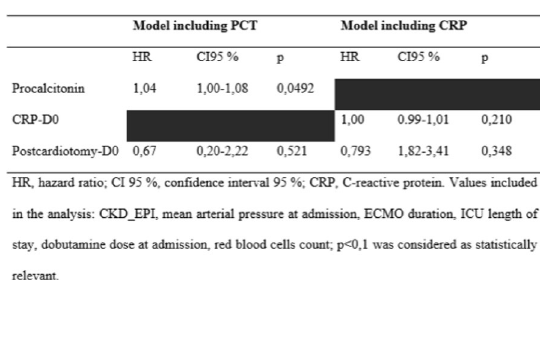
P‑168 Does the infusion speed impact the haemodynamic effect of a fluid bolus in septic shock patients? A